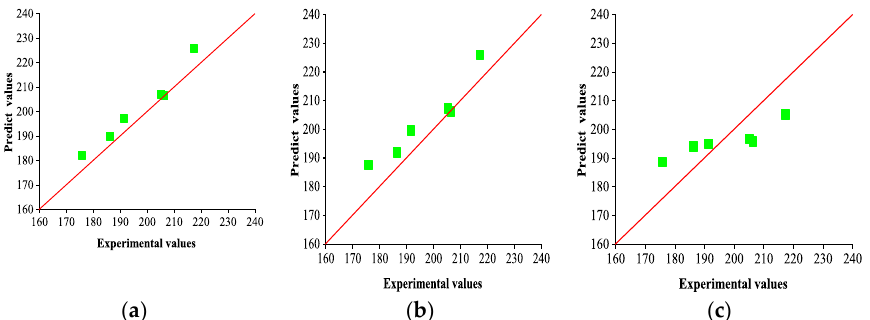
Figure 10. Comparison of the accuracy of the predicted nugget diameter of different models. ( a ) CGO–MLSSVR prediction model; ( b ) MLSSVR prediction model; ( c ) GRNN prediction model. Figure 11. Comparison of the accuracy of the predicted tensile shear load of different models. ( a ) CGO–MLSSVR prediction model; ( b ) MLSSVR prediction model; ( c ) GRNN prediction model.